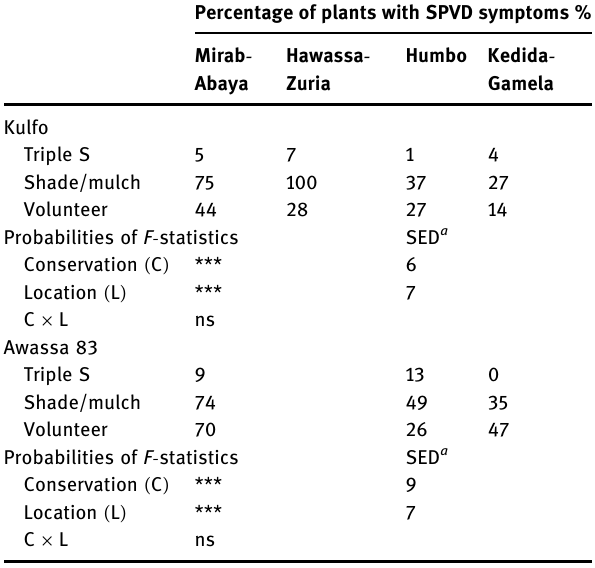
Table 4: E ff ect of conservation method and location on percentage of plants with SPVD